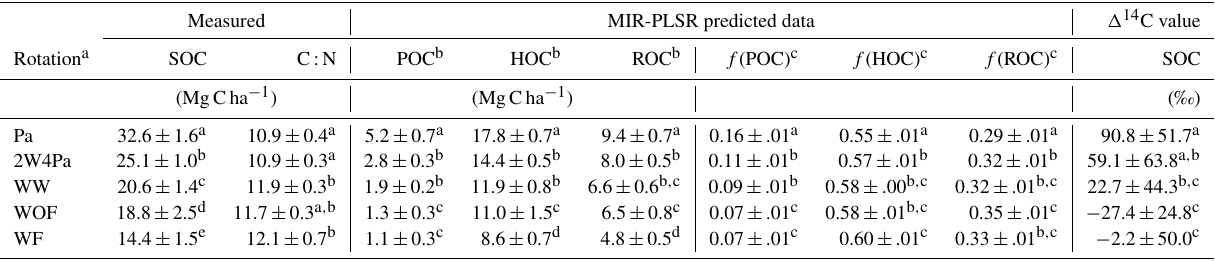
Table 2. Soil carbon data summary. Mean across time and standard deviation given for each rotation. Significant differences (one-way repeated-measures ANOVA, α< 0 . 05) between rotations are indicated with different letters in each column.